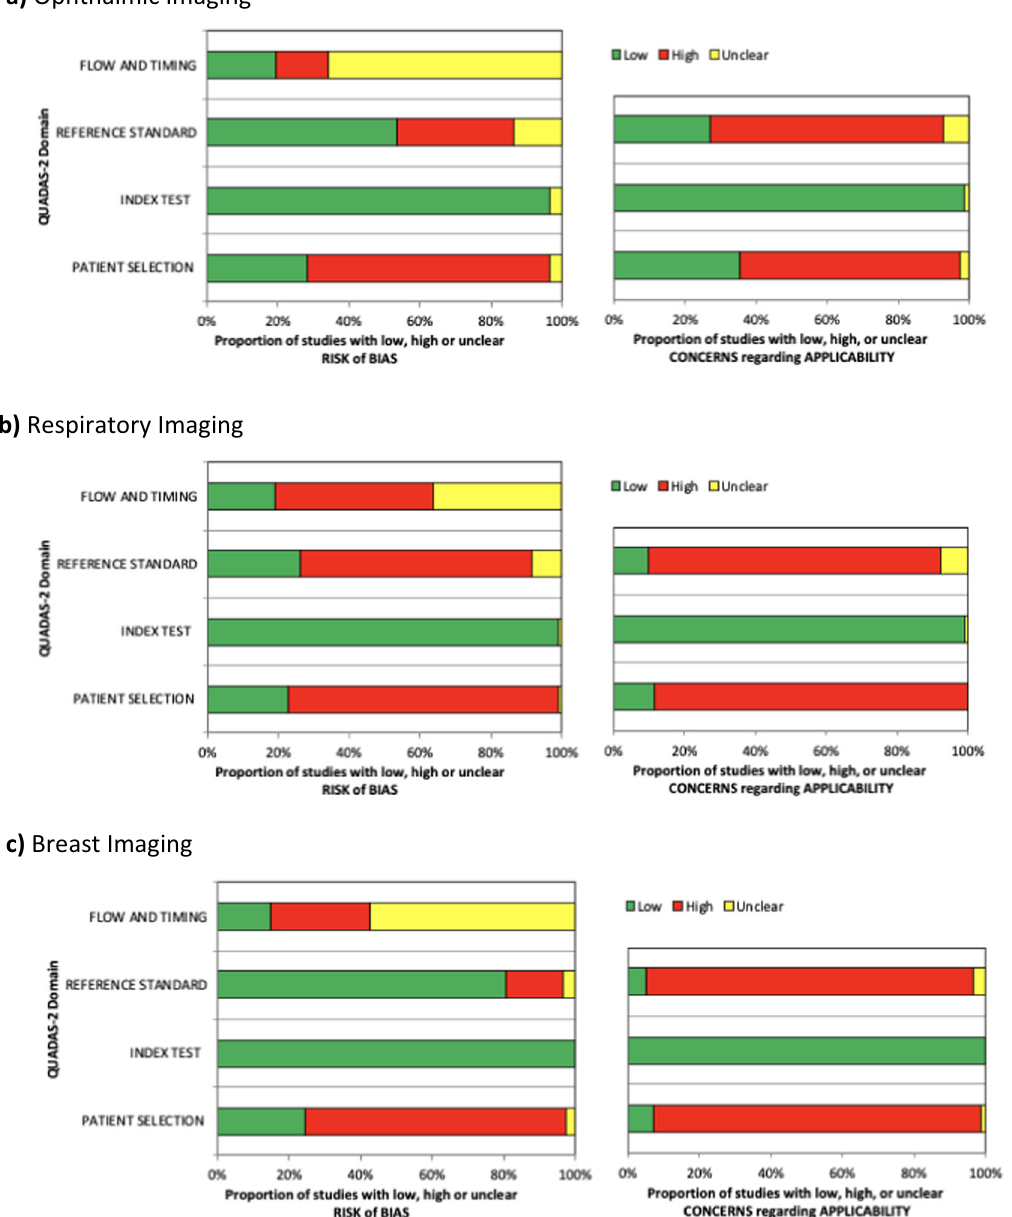
Fig. 2 QUADAS-2 summary plots. Risk of bias and applicability concerns summary about each QUADAS-2 domain presented as percentages across the 82 included studies in ophthalmic imaging ( a ), 115 in respiratory imaging ( b ) and 82 in breast imaging ( c